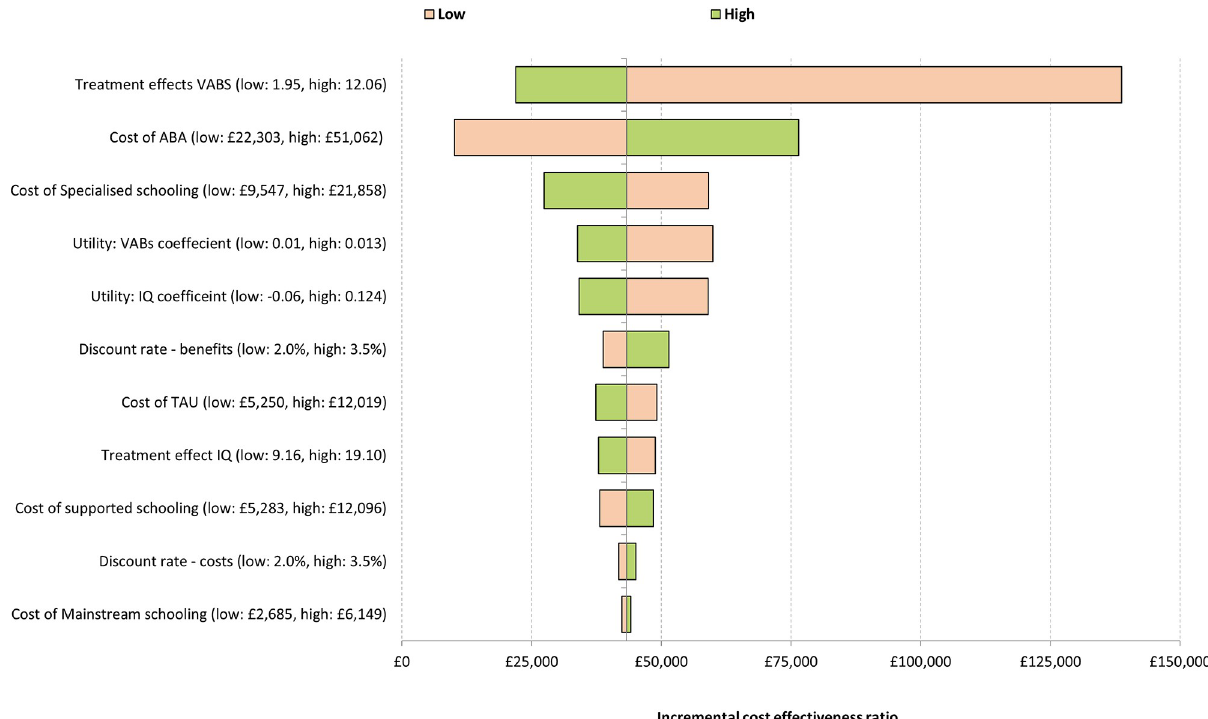
Fig 3. Tornado diagram (optimistic analysis).